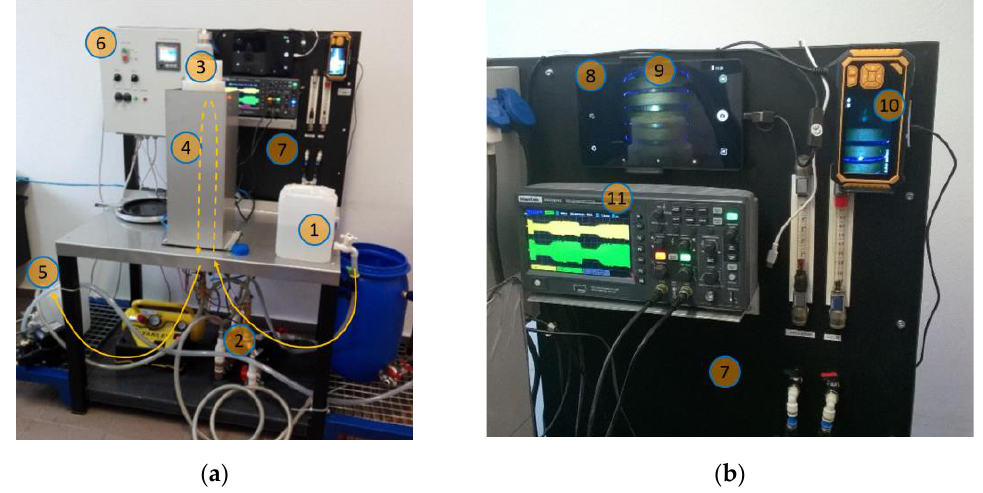
Figure 2. Experimental lab stand with nonthermal plasma reactor (yellow arrows indicate the direc- tion of water flow). ( a ) Metering and visualization panel; ( b ) 1 — source tank, 2 — pump, 3 — quartz tube enclosed in a case, 4 — metallic shield against electric field, 5 — destination tank, 6 — supply panel, 7 — control and visualization panel, 8 — main monitor, 9 — coil visible on the main monitor, 10 — auxiliary monitor (visible coil turns and blue light of discharges), 11 — scope with visible voltage and current waveforms in the coil.